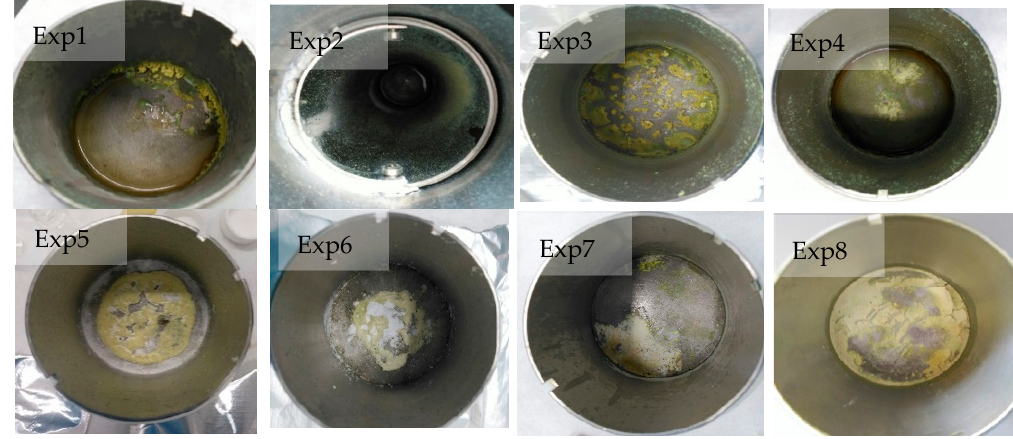
Figure 3. Deposition images of the bottom of the precipitator vessel, experiments 1–8.